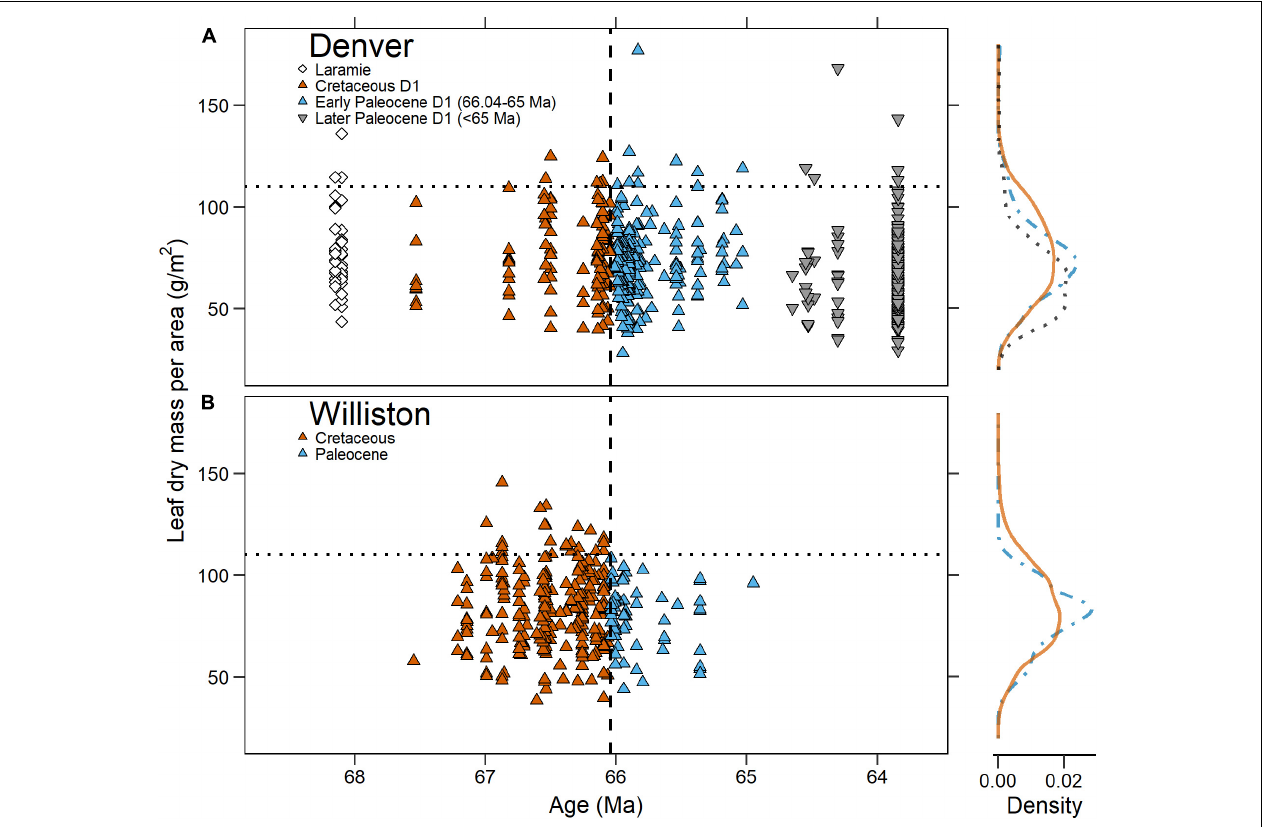
FIGURE 5 | Mean leaf dry mass per area (LMA) of species-site pairs plotted against time in the (A) Denver Basin and (B) Williston Basin. In both, the vertical dashed line is the Cretaceous-Paleogene boundary and the horizontal dotted line is the 110 g/m 2 cut-off for high LMA species observed in the Williston Basin. To the right are probability density functions for each basin. The solid orange line represents Cretaceous D1 species-site pairs in the Denver Basin and Cretaceous species-site pairs in the Williston. The blue dot-dash line represents early Paleocene D1 species-site pairs in the Denver Basin and Paleocene species-site pairs in the Williston. The black dotted line represents Later Paleocene D1 species-site pairs in the Denver Basin.